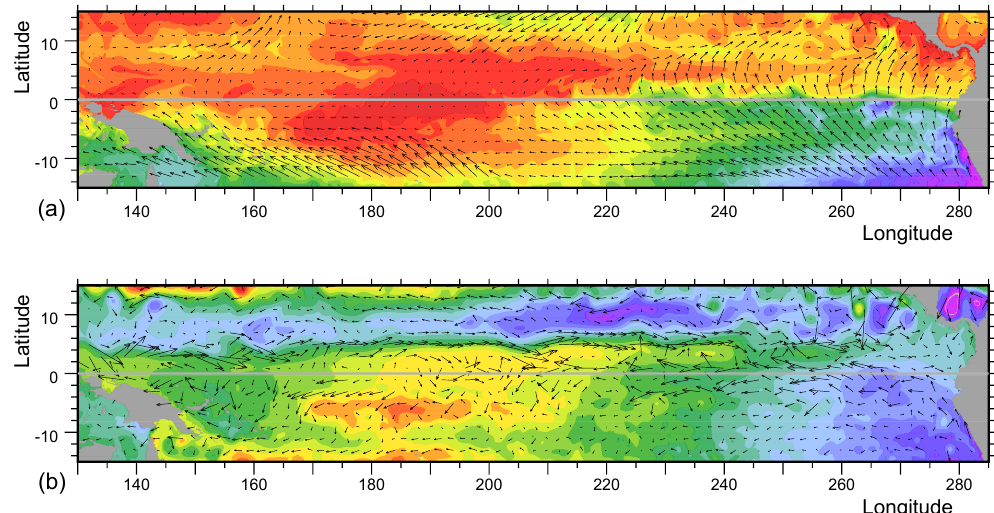
Figure 35. (a) Surface temperature and wind stress vectors. (b) SSH and velocity vectors are from the 27 September 1997 archive dataset. Colours and vector scales are as in Fig.